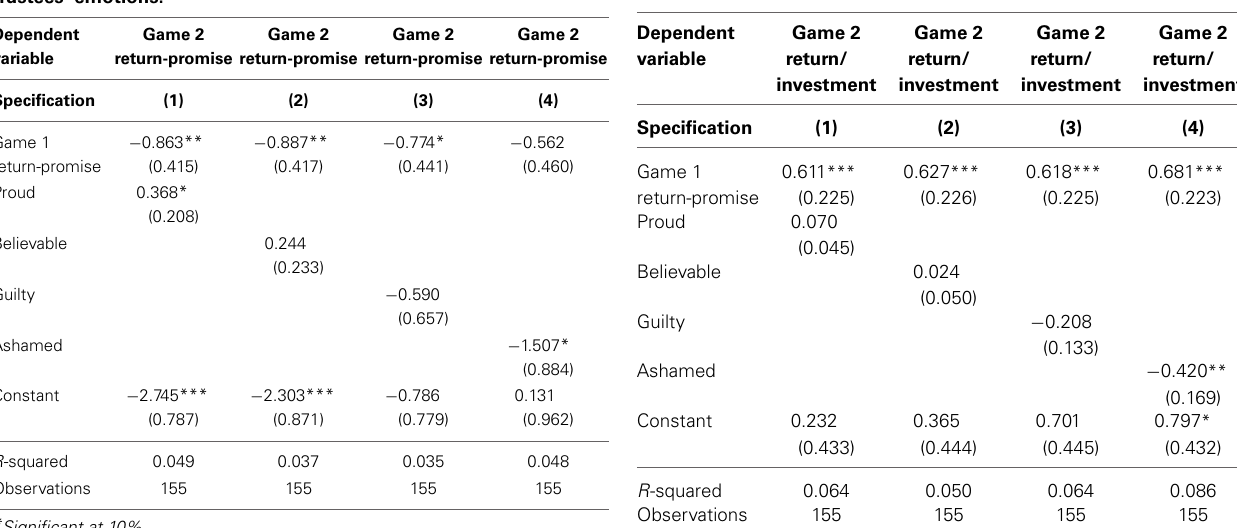
Table 10B | Regression of game 2 ROI on promise keeping